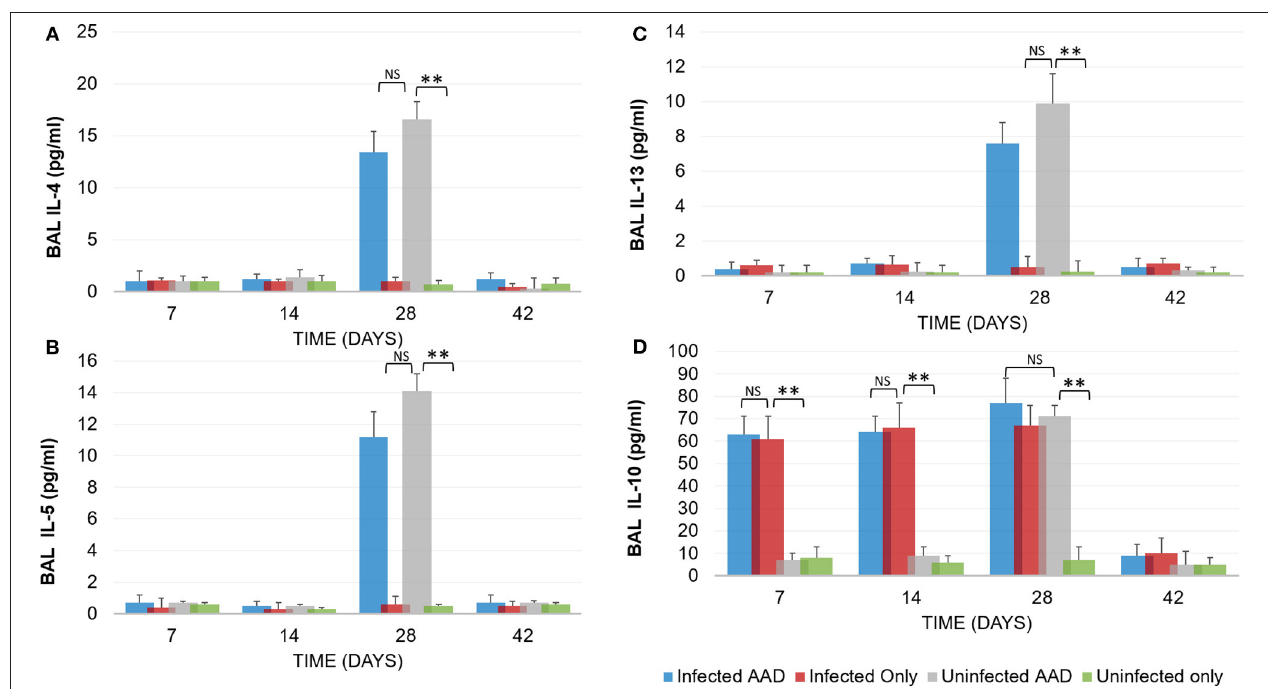
FIGURE 4 | TH2 Cytokine production by AAD induced mice. Following the induction of AAD using Ova as described in the methods, both infected and uninfected animals ( N = 5 animals per group) produced elevated amounts of IL-4, IL-5 and IL-13 (A–C) . Infected animals produced IL-10 throughout the treatment period until clearance of the organism from the lungs (D) . Uninfected animals with AAD induced also produced elevated levels of IL-10. All cytokine levels declined by day 42 when Chlamydia was cleared from the lung tissue. ** P < 0.0001 for uninfected controls compared to infected animals; NS represents a p -value that is not significant. There was no significant difference in cytokine levels between infected AAD and uninfected AAD animals for these Th2 cytokines. Results are representative of 2 independent experiments.